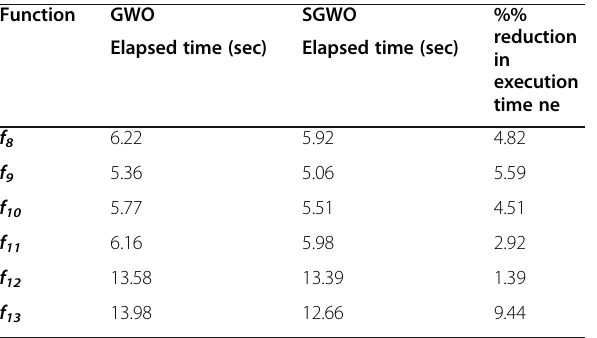
Table 5 Comparison of computational time between GWO and SGWO for multimodal functions Function GWO SGWO